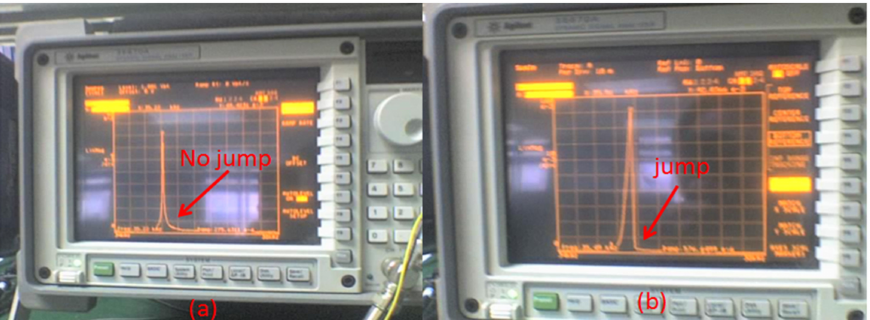
Figure 6. Amplitude–frequency curve of single resonant beam. In the amplitude–frequency curve ( a ) there is no jump; ( b ) there is a